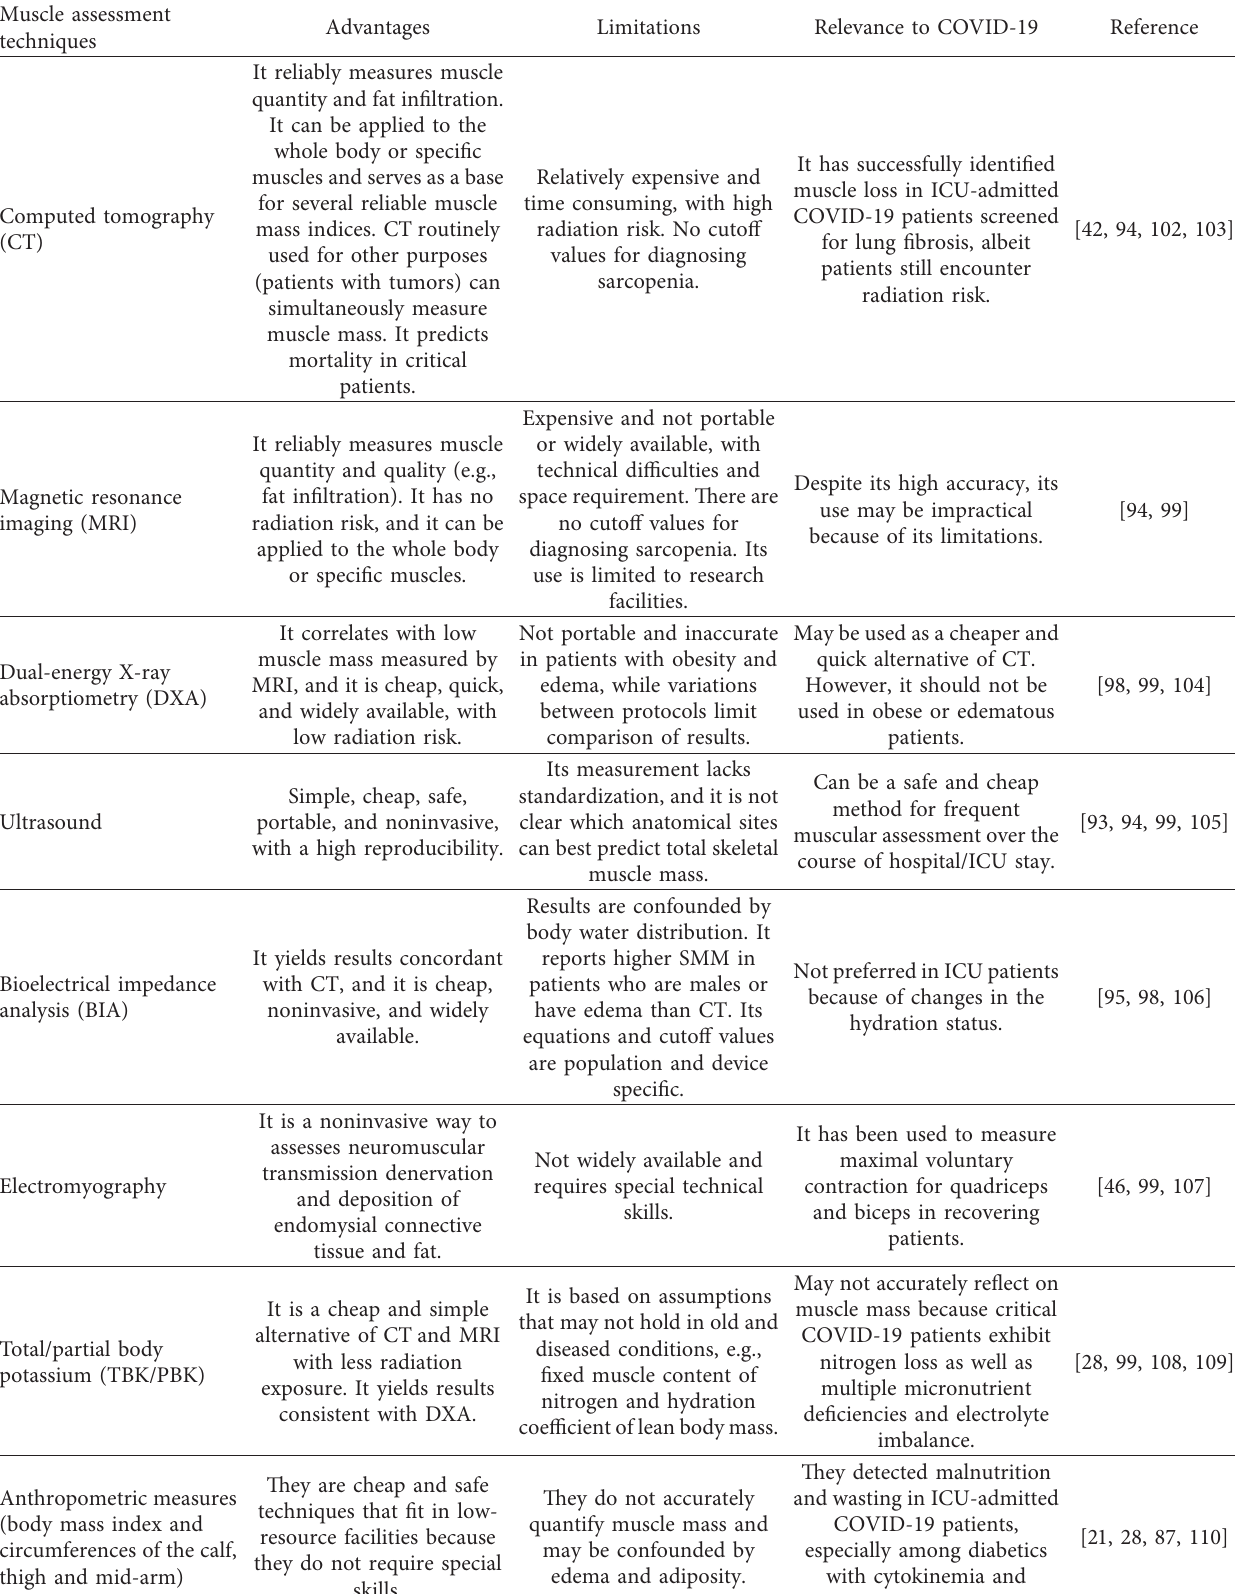
Table 1: Advantages and possible limitations of different techniques used for assessing sarcopenia and the likelihood for their application in COVID-19